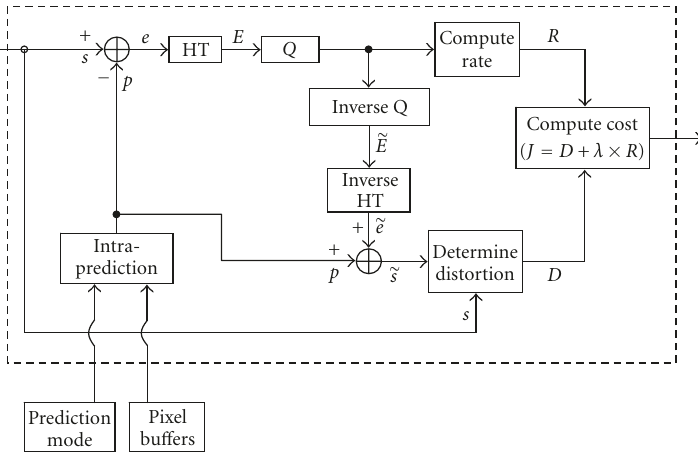
Figure 6: Pixel-domain RD cost calculation.